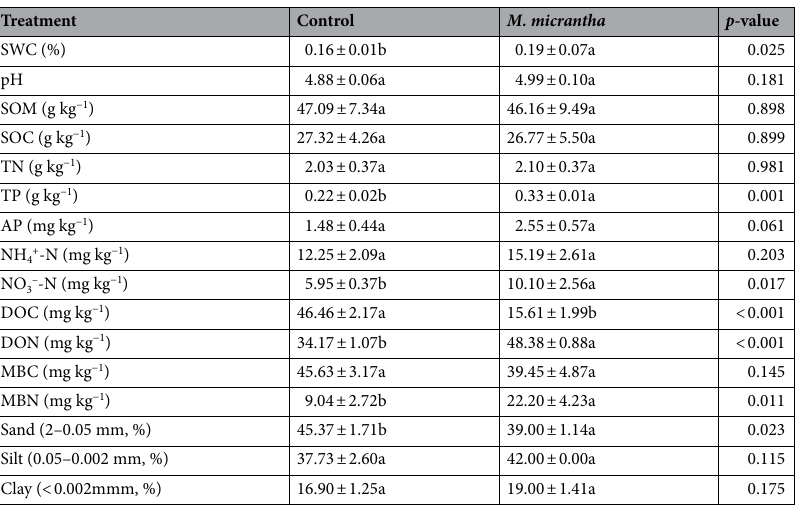
Table 1. Basic physicochemical characteristics of soils of the pristine forest forests and M. micrantha -invaded forest. Values are mean (n = 5). Different lowercase letters indicate significant differences at three altitudes in the same horizon. SOM Soil organic matter, SOC Soil organic carbon, TN Total nitrogen, TP Total phosphorus, AP Available phosphorus, NH